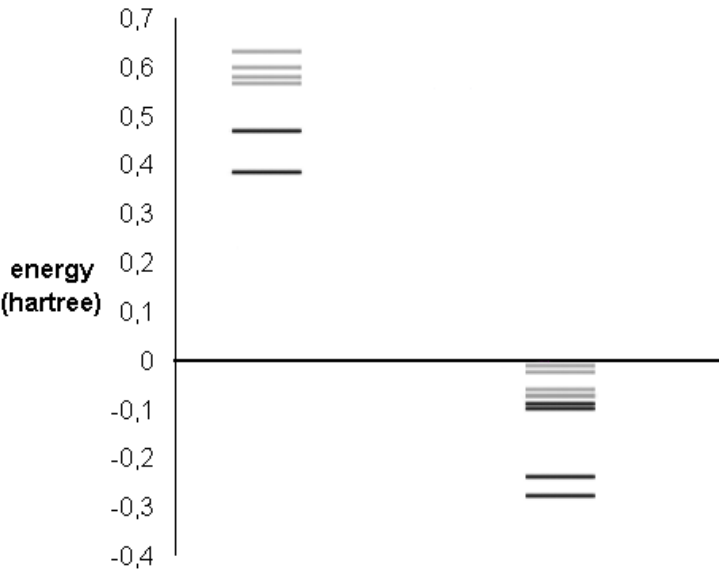
Figure 2. [MnCN ] 4- (on the left) and Na 6 level. Black color denotes occupied, and gray color denotes unoccupied orbitals. The gap between between HOMO and LUMO for the Na ] 4- [MnCN 6